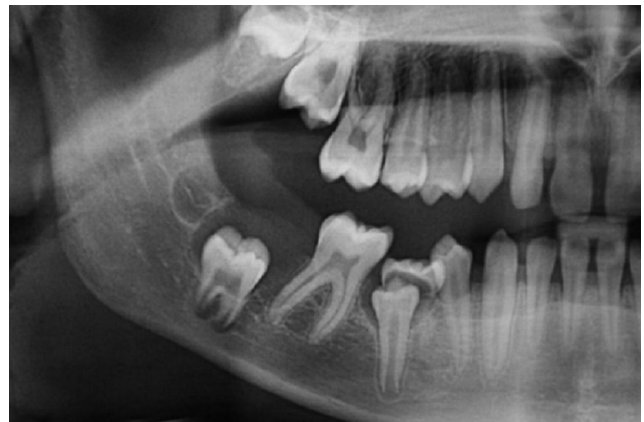
Figure 2. Panoramic radiography made at the age of thirteen: A unilocular well-defined radiolucent lesion (measuring around 4 mm) surrounding impacted mandibular right second molar.